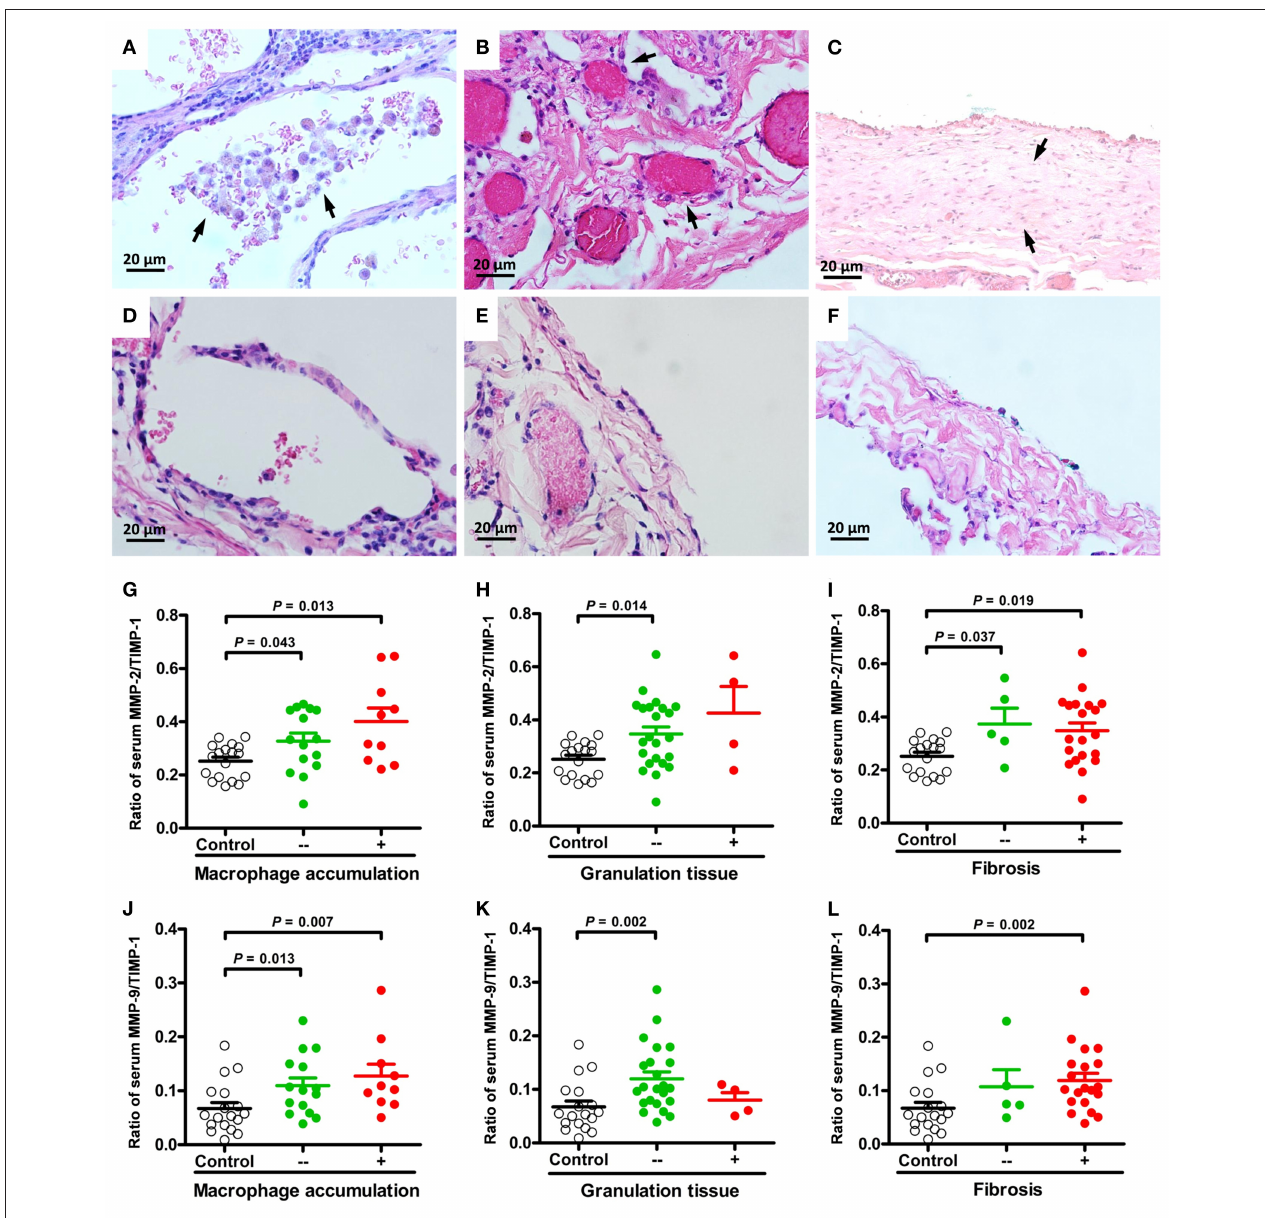
FIGURE 1 | Representative micrographs (H&E, × 400) of macrophage accumulation, granulation tissue, and fibrosis in lung specimens of PSP patients. Aggregates of macrophages in the alveolar spaces [ (A) arrows] compared to normal appearance (D) . Excessive proliferation of granulation tissue in the pleura [ (B) arrows] compared to normal appearance (E) . Clearly delineated areas of pleural/subpleural fibrosis in non-fibrotic parenchyma [ (C) arrows] compared to normal appearance (F) . Comparisons and differences of serum MMP-2/TIMP-1 and MMP-9/TIMP-1 ratios between PSP patients with and without macrophage accumulation (G,J) , granulation tissue (H,K) , fibrosis (I,L) and healthy